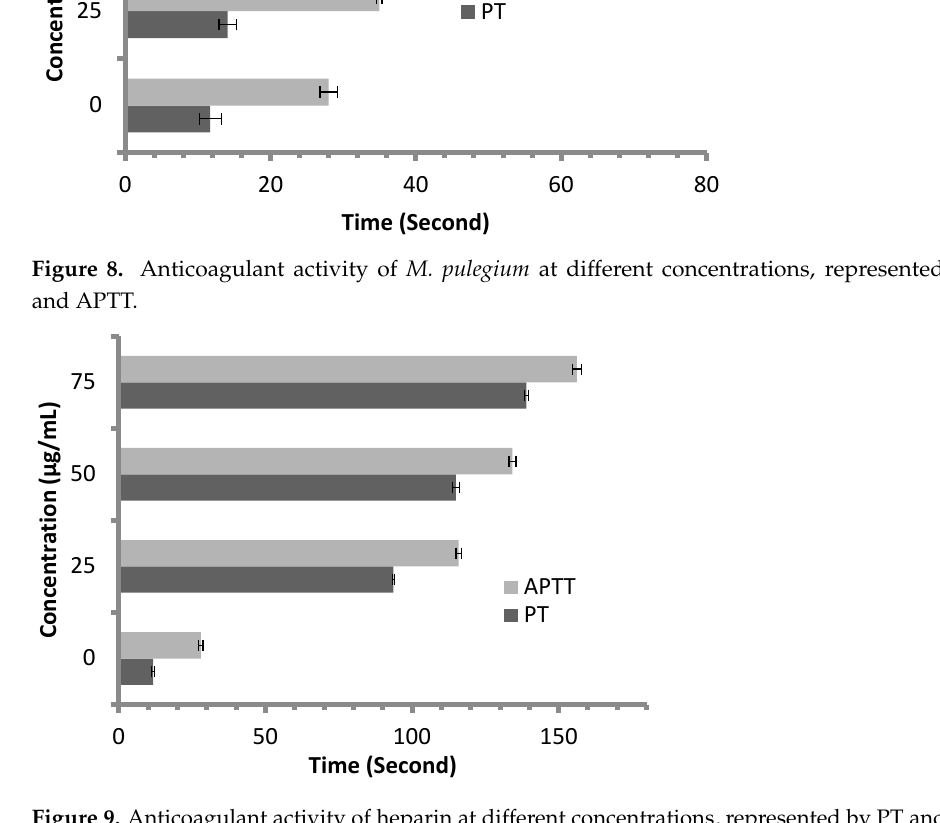
Figure 9. Anticoagulant activity of heparin at different concentrations, represented by PT and APTT.